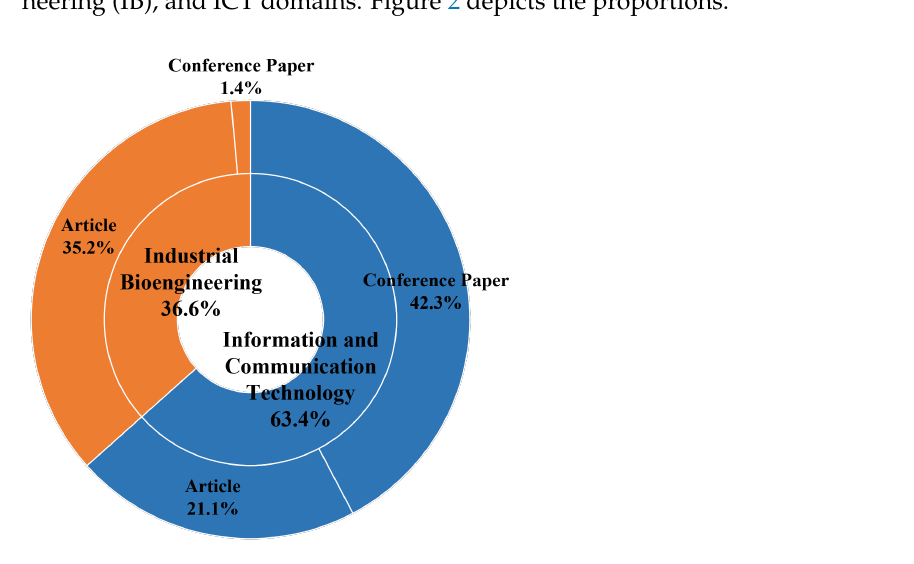
Figure 2. Distribution of papers according to ICT and IB categories, conference papers, and articles.